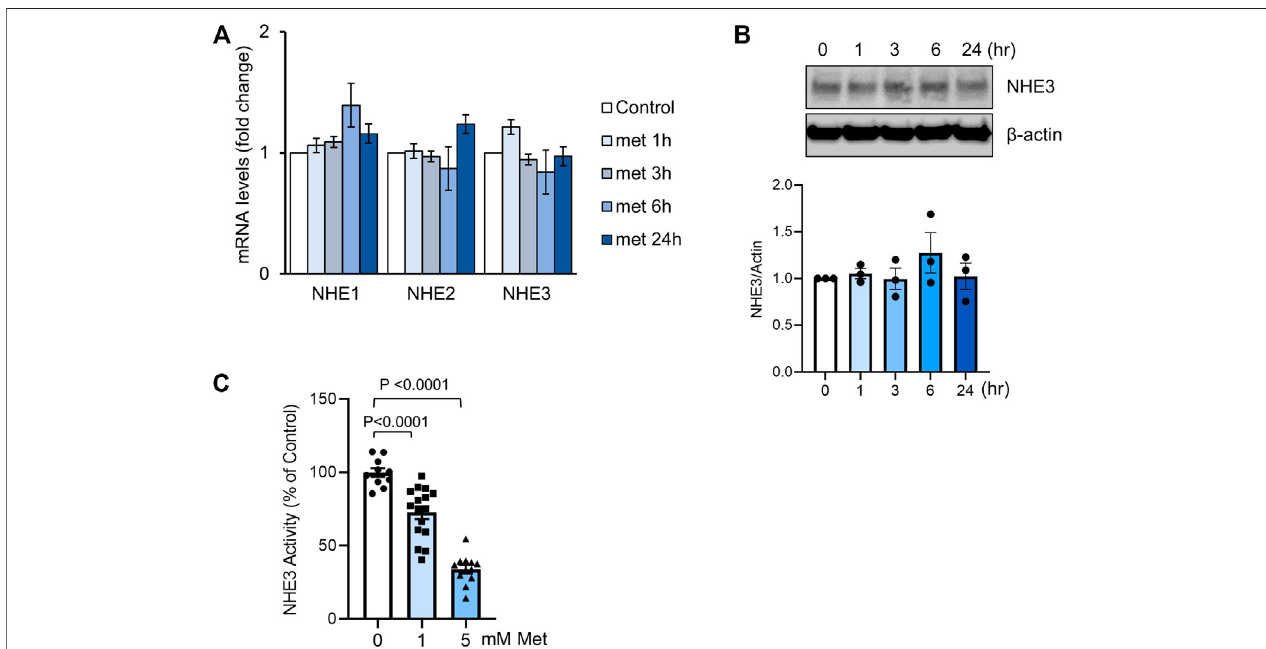
FIGURE 2 | Metformin inhibits NHE3 activity. (A) SK-CO15 cells were treated with metformin for indicated time duration. Transcript levels (mean ± SEM) of NHE1, NHE2 and NHE3 were determined by RT-PCR. n = 9. (B) NHE3 protein expression in SK-CO15 cells treated with metformin was determined. ß -actin was used as a loading control. Graph below shows NHE3 expression levels relative to ß -actin. n =3. (C) NHE3 activity wasdetermined by measuring the initial rates ofNa + -dependent changes in intracellular pH (pH i ) in Caco-2bbe cells expressing human NHE3. Cells were treated with 1 or 5 mM metformin for 30 min. Results are presented as percent (mean ± SEM) of NHE3 activity at 0 mM metformin. n = 11 – 17. One-way ANOVA.